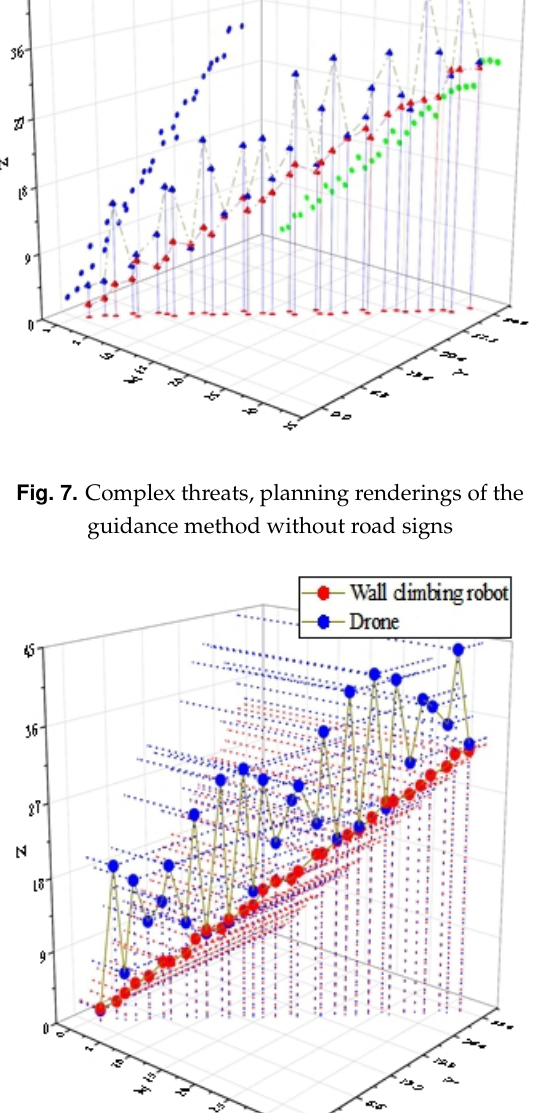
Fig. 8. Complex threat, planning effect diagram of road sign guidance